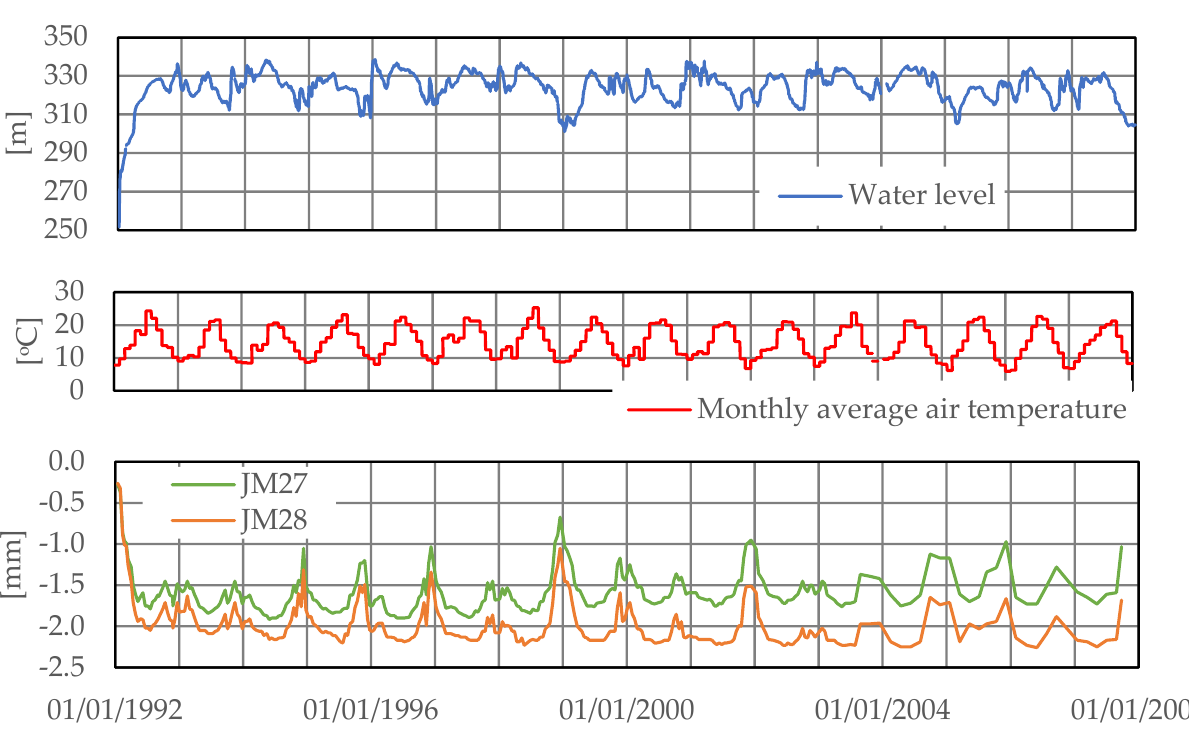
Figure 2. Reservoir levels, monthly average air temperature, and joint-meters movements.